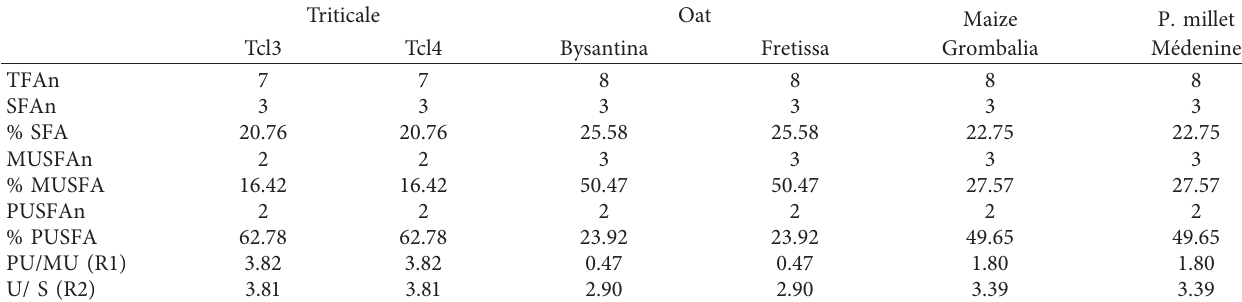
Table 7: Number and amount of the different fatty acids fractions of triticale, oat, maize, and pearl millet varieties. Triticale Oat Maize P. millet Tcl3 Tcl4 Bysantina Fretissa Grombalia M´edenine